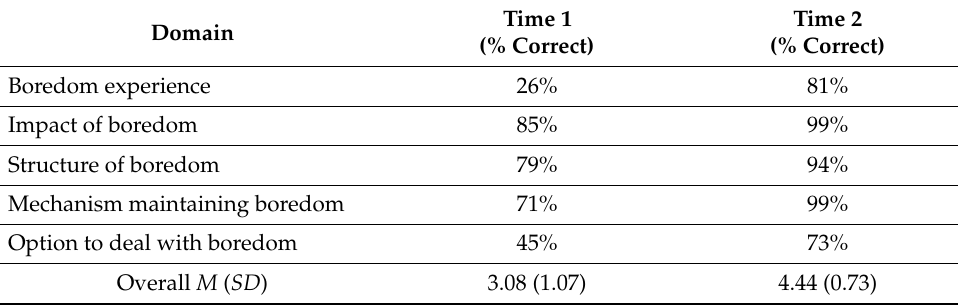
Table 3. Knowledge-based multiple-choice domains, frequencies, and